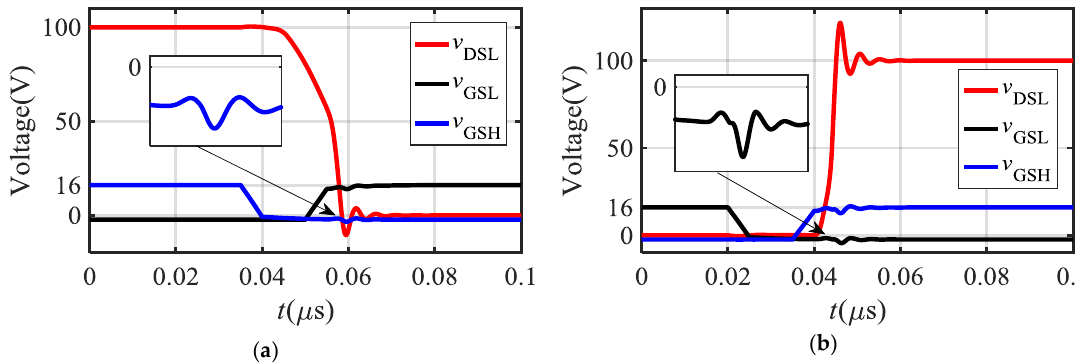
Figure 9. Switching waveform captured from simulation ( a ) during turn-on of low-side MOSFET ( b ) during turn-off of low-side MOSFET.